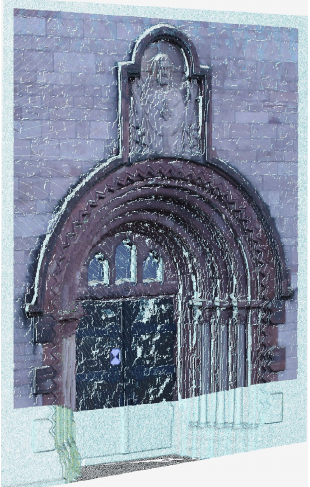
Figure 11. Registration of the reconstructed point cloud onto the ground truth data ( Herz-Jesu-K7